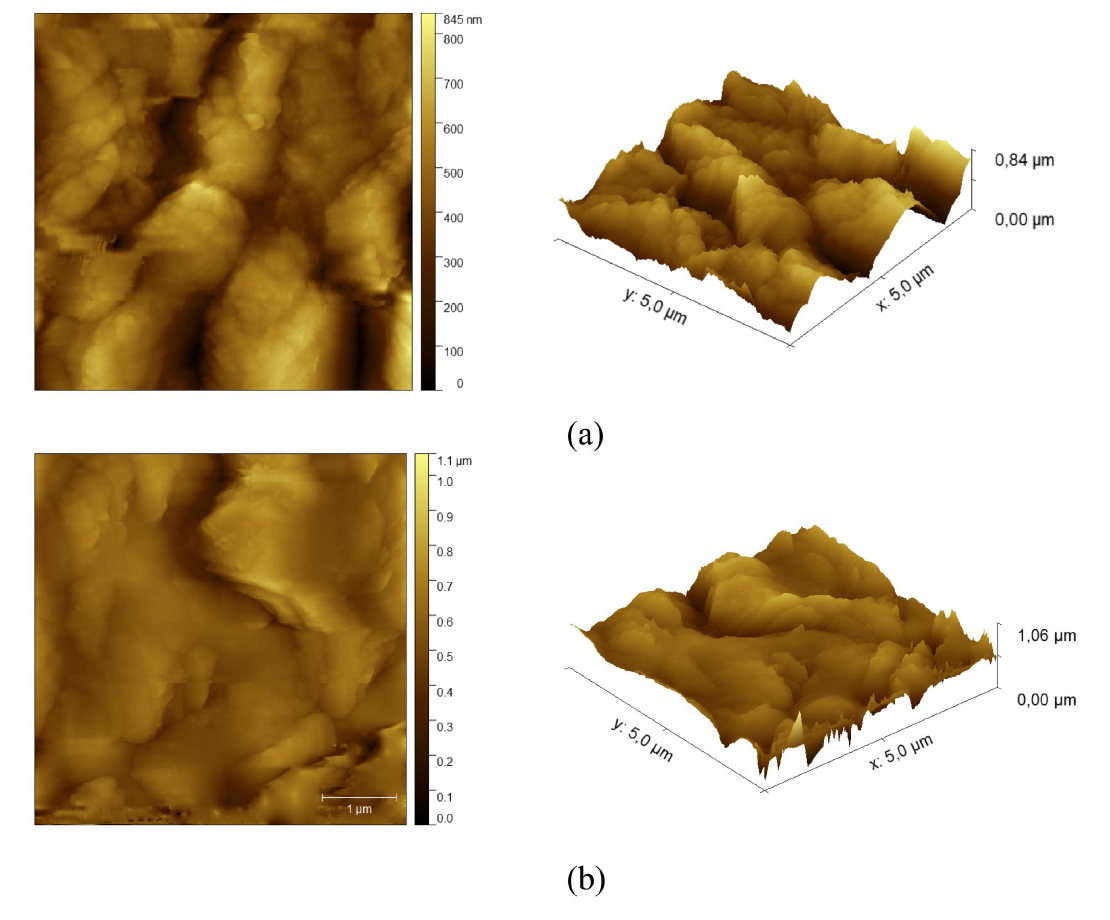
Figure 5. Surface profiling of the (a) M1 and (b) M2